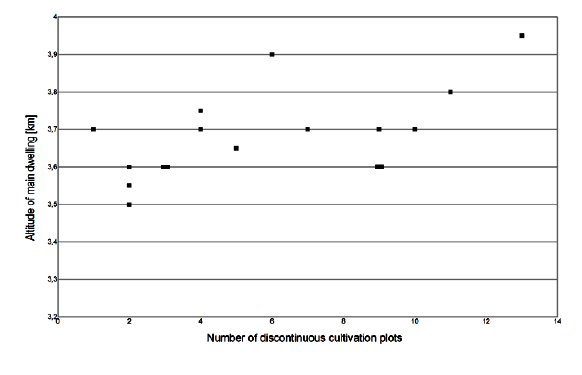
Fig. 3 . Chorojo: number of cultivated plots of 17 households in relation with altitude.